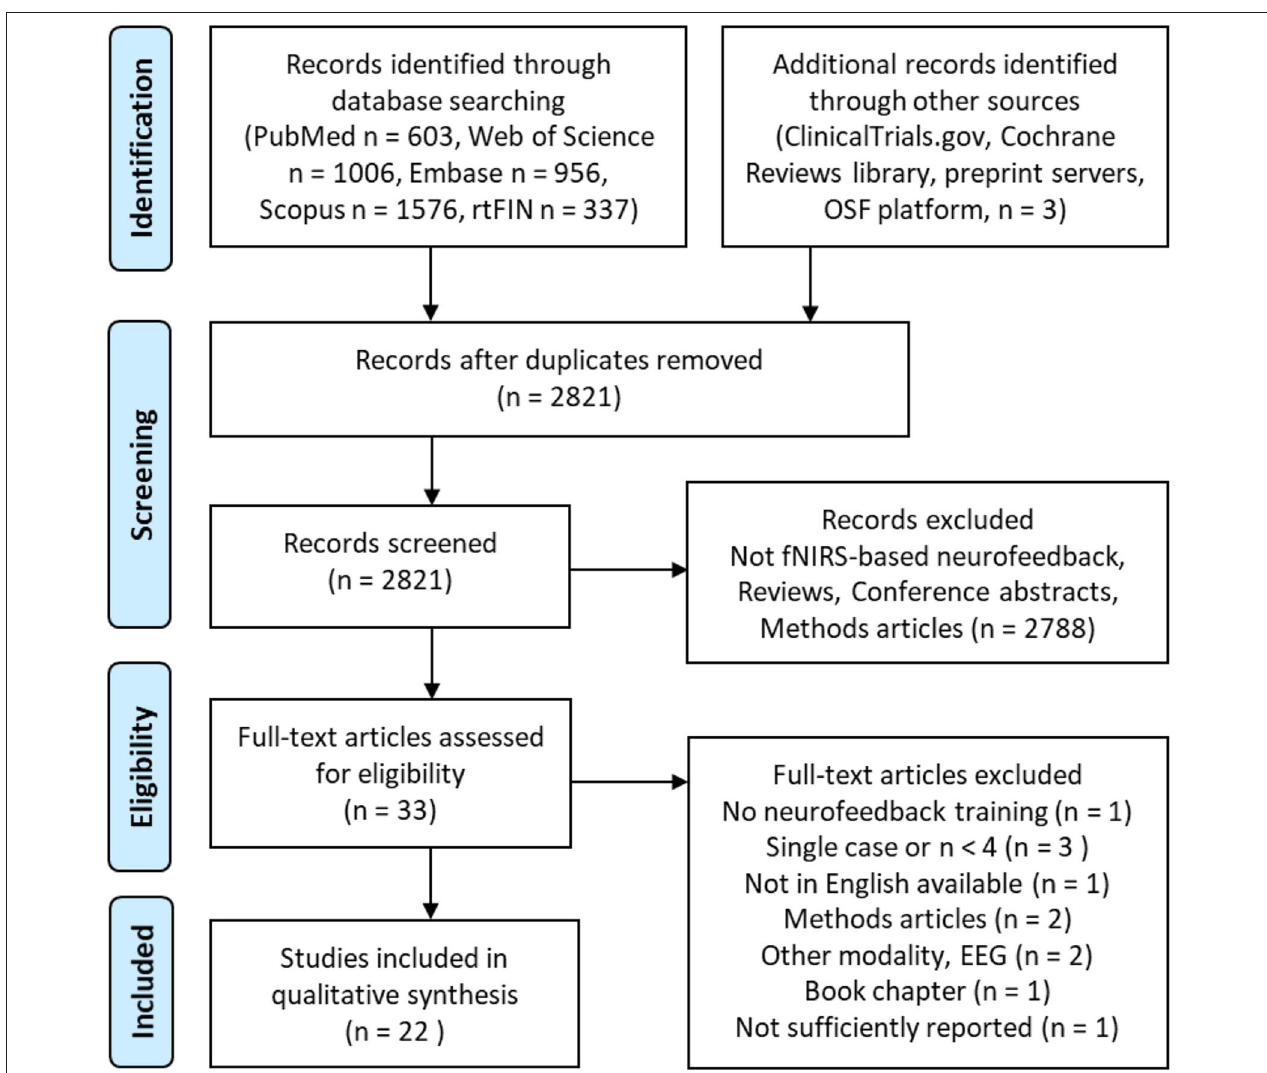
FIGURE 1 | Search decision flow diagram according to preferred reporting items for systematic reviews and meta-analyses (PRISMA; Moher et al., 2009).